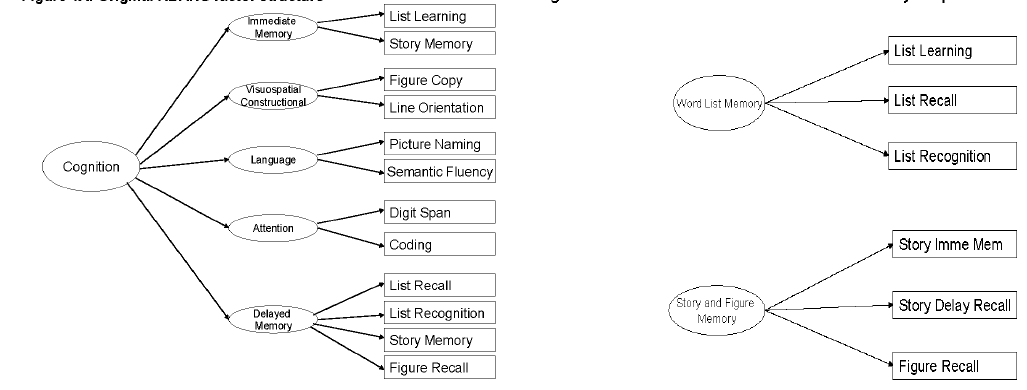
Figure 1. Factor structure of the RBANS: Original vs. refined for early PD patients